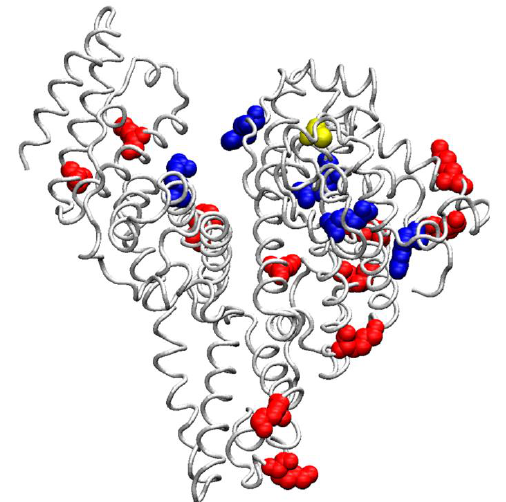
Figure 1. The main sites of HSA modification. The sites of in vivo glycation are shown in red (ly- sines) and blue (arginines). The site of redox modification (Cys34) is shown in yellow. To create the figure, a crystal structure of HSA from the PDB database (code 3JQZ [24]) was used. 2. Transporting Function and Structural Characteristics of Albumins of Different Spe-